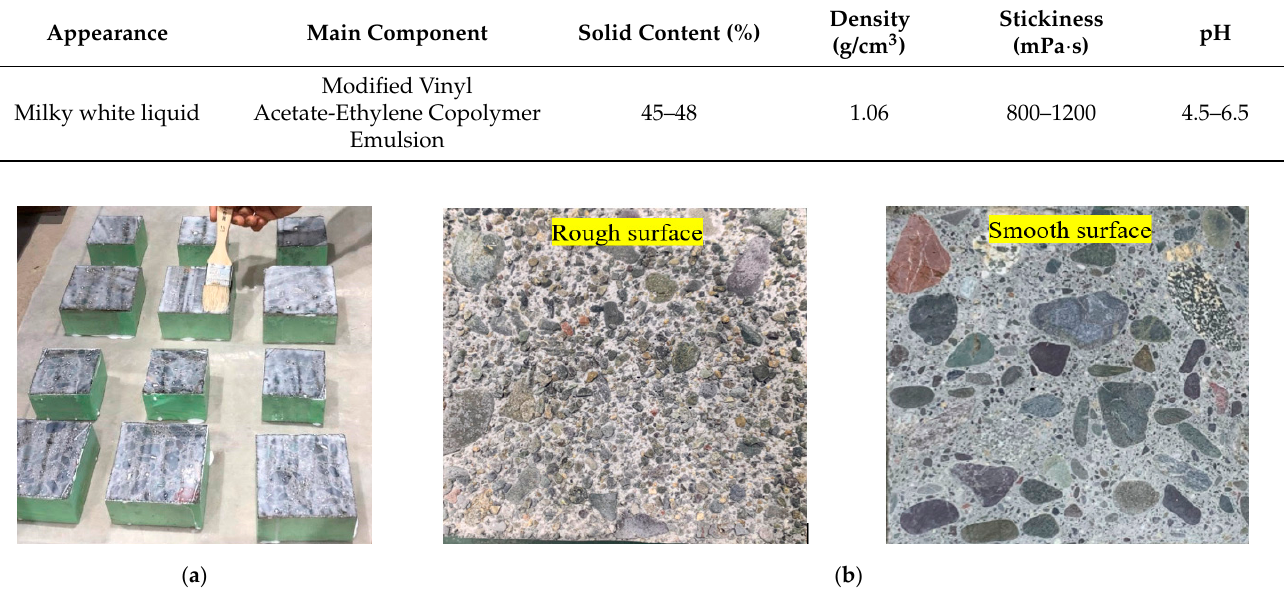
Figure 1. Treated surface of substrate concrete interface. ( a ) Application of primer. ( b ) Concrete substrate roughness level used in this study. Table 3. Technical characteristics of primer.